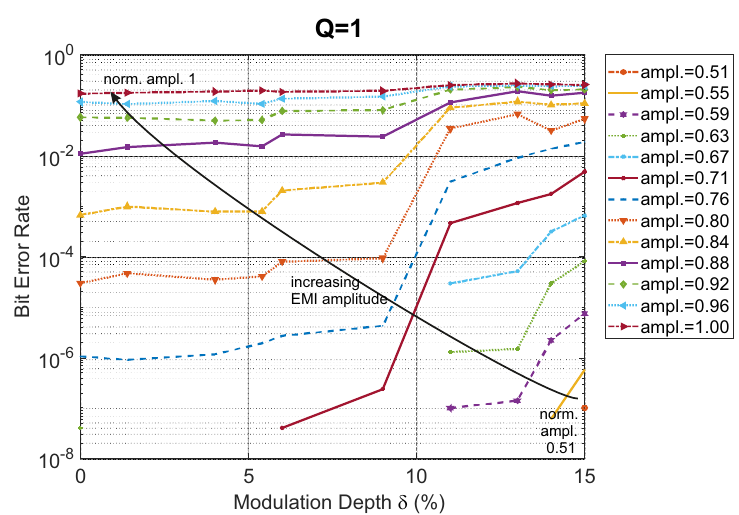
Figure 13. Bit error rate of a communication channel corrupted by SS-modulated EMI under weakly resonant coupling ( Q = 1) vs. different modulation depth δ at different EMI normalized r.m.s. amplitude values.